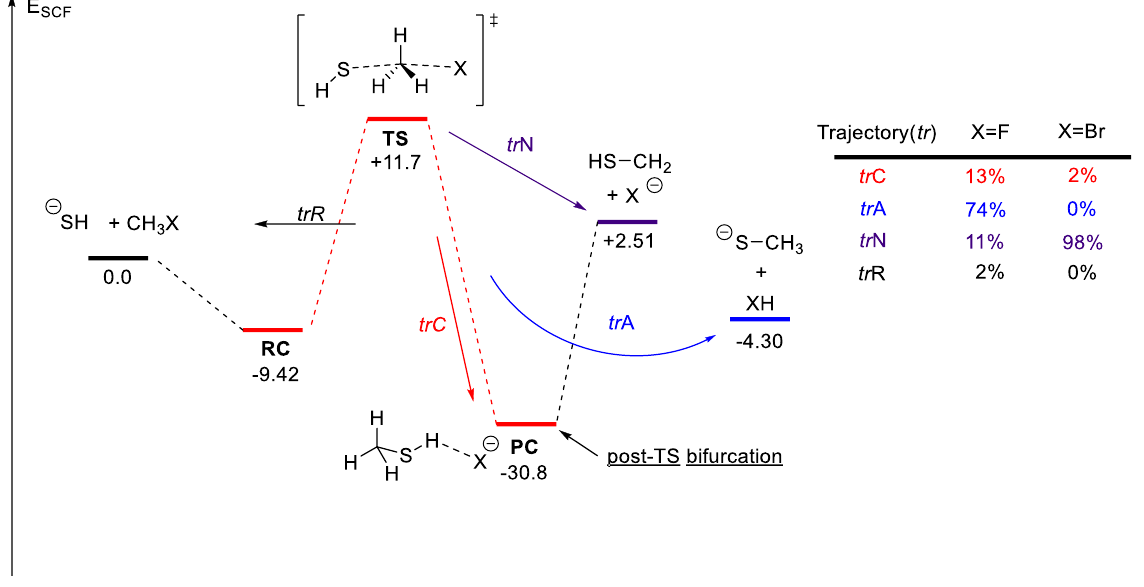
Figure 13. Values (in kcal/mol) calculated at MP2/6-311(d,p) are obtained from ref [134]. trC: approximately IRC path. trA: approximately IRC path followed by a proton transfer. trN: bypass the IRC path to form the product directly. trR: recrossing.